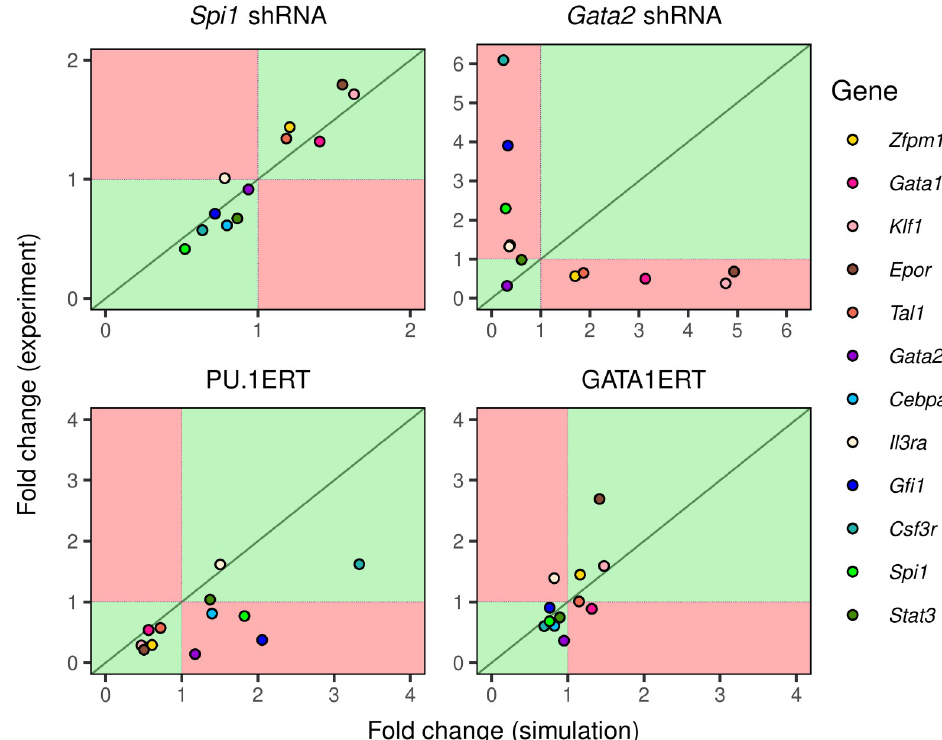
Fig 3. Simulation of knockdown and overexpression of key transcription factors in FDCP-mix cells. The fold change in gene expression in simulations of Spi1 and Gata2 knockdown (top two panels) or PU.1 and Gata1 overexpression (bottom two panels) is plotted against the fold change observed in experiment. The dotted lines correspond to no change so that points in the green quadrants indicate qualitative agreement and points in the red quadrants indicate qualitative disagreement between prediction and observation. The green line represents perfect quantitative agreement between prediction and observation.